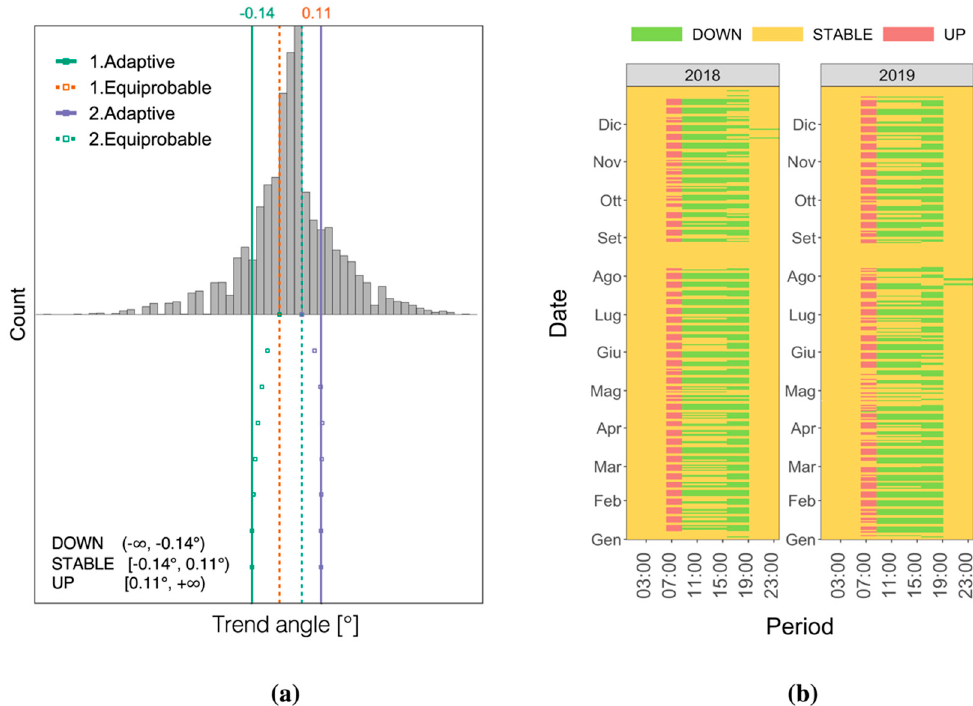
Figure 11. Results of trend angle aSAX encoding applied to the rectory sub ‐ load: ( a ) identification of adaptive breakpoints through the aSAX algorithm, ( b ) encoded trend angle carpet plot for 2018 and 2019.